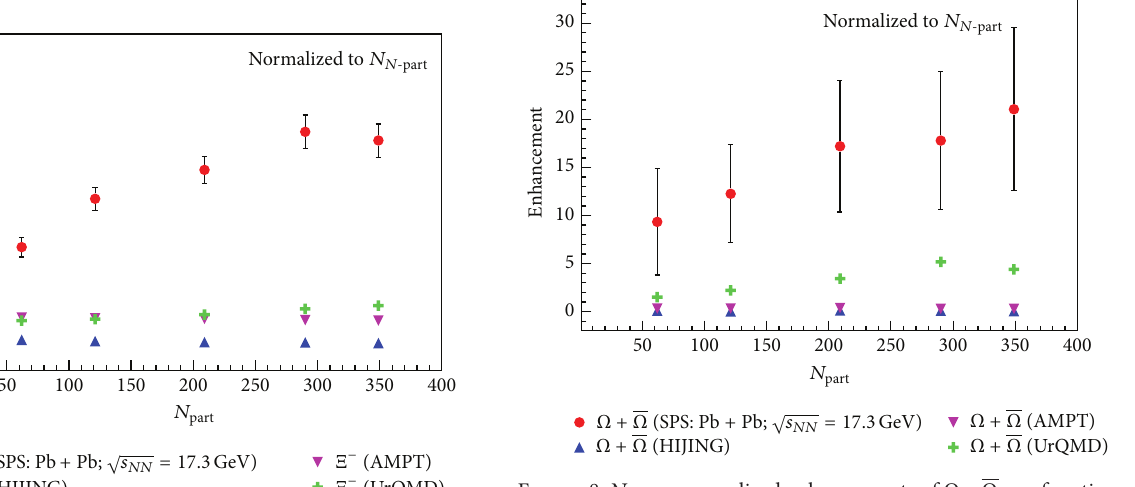
Figure 8: 𝑁 𝑁 -normalized enhancements of Ω + Ω as a function -part of centrality for Pb + Pb collisions at √𝑠 𝑁𝑁 = 17.3 GeV compared with HIJING, AMPT, and UrQMD models at